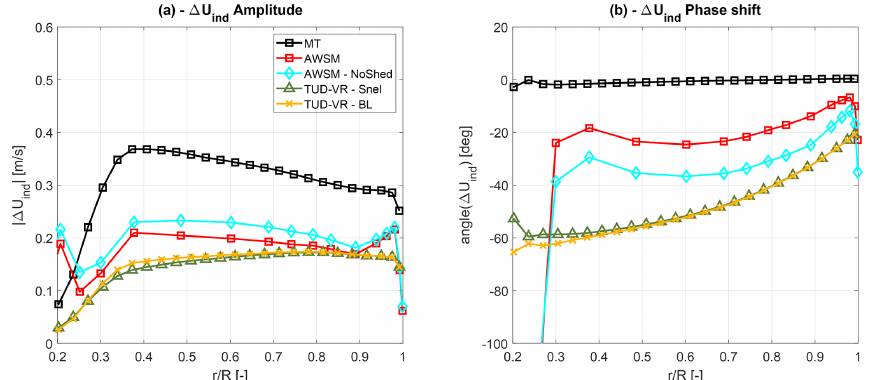
Figure 9. Effect of the shed vorticity on the 50mHz sinusoidal pitch variation above rated conditions (a) on the distribution of the axial induced-velocity variation amplitude at the blade pitch frequency and (b) on the distribution of the axial induced-velocity variation phase at the blade pitch frequency, with respect to the phase of the prescribed pitch time series.